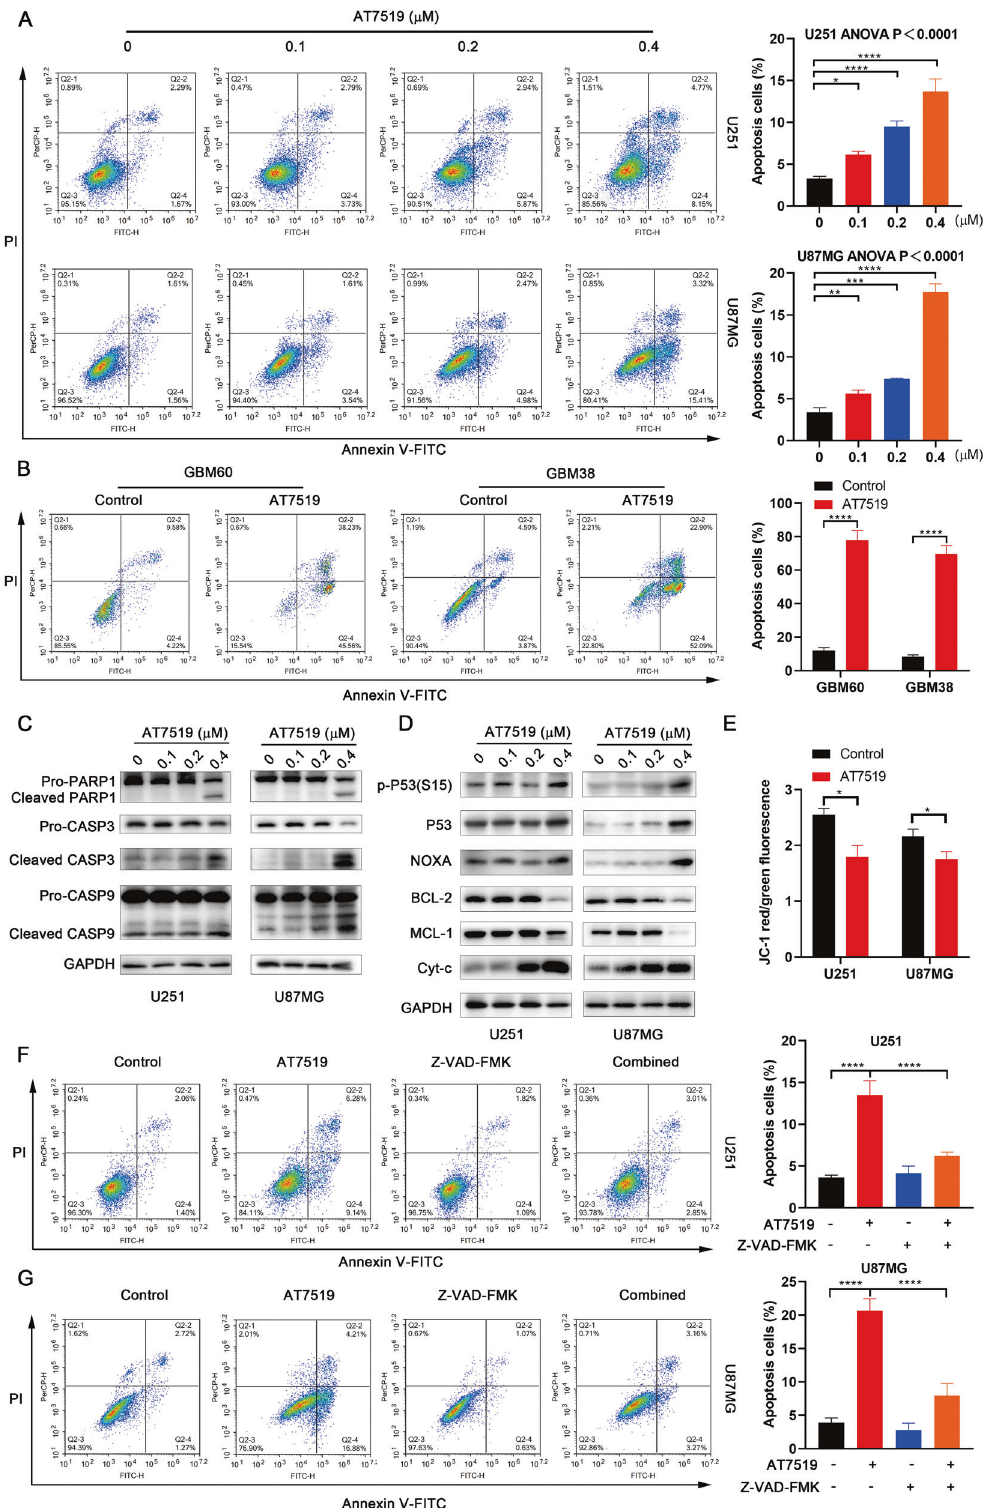
Fig. 4 AT7519 induces apoptosis in glioblastoma cells. A , B After treatment of U87MG, U251, and GBM-derived primary cells with AT7519 for 48 h, the percentage of cells undergoing apoptosis was detected by fl ow cytometry using PI/Annexin V-FITC double staining. * P < 0.05, ** P < 0.01, *** P < 0.001, and **** P < 0.0001 as determined by one-way ANOVA followed by Dunnett ’ s multiple test. C , D Western blotting detection of proteins associated with apoptosis in U87MG and U251 cells treated with 0.1, 0.2, or 0.4 μ M AT7519 for 48 h. E Mitochondrial membrane potential was displayed by change in the ratio between red (aggregated JC-1) and green (monomeric JC-1) fl uorescence intensity measured by spectro fl uorimeter. * P < 0.05 by Student ’ s t -test. F , G U87MG and U251 cells were treated with AT7519 following 2-h pretreatment with Z-VAD-FMK or DMSO, and the apoptosis ratio was detected by fl ow cytometry using PI/Annexin V-FITC double stain. **** P < 0.0001 as determined by Student ’ s t -test. Cell Death and Disease (2023)